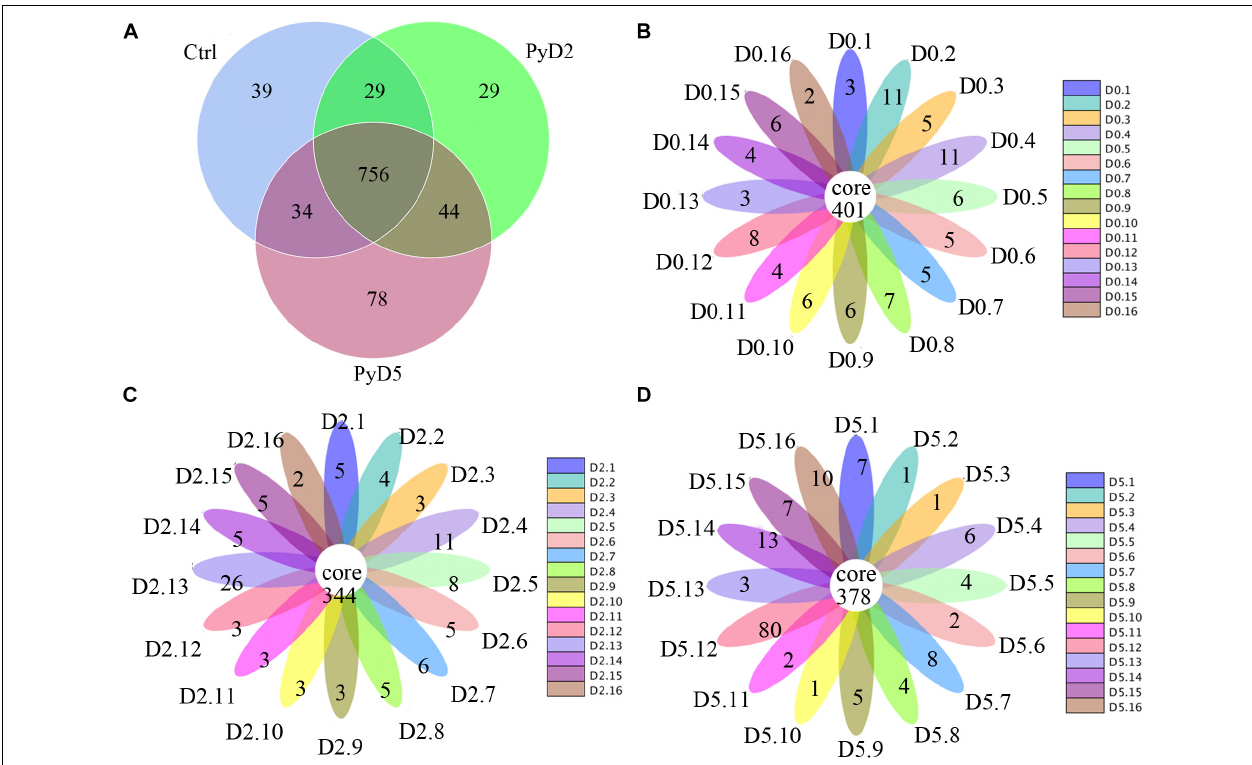
FIGURE 2 | Operational taxonomic unit (OTU) analysis in the different fecal samples. (A) Venn diagram showing the unique and shared OTUs in the various groups and communities. (B) Flower diagram showing the shared and unique OTUs in the Ctrl samples. (C) Flower diagram showing the exclusive and mutual OTUs in the PyD2 samples. (D) The flower diagram shows the exclusive and mutual OTUs in the PyD5 samples.